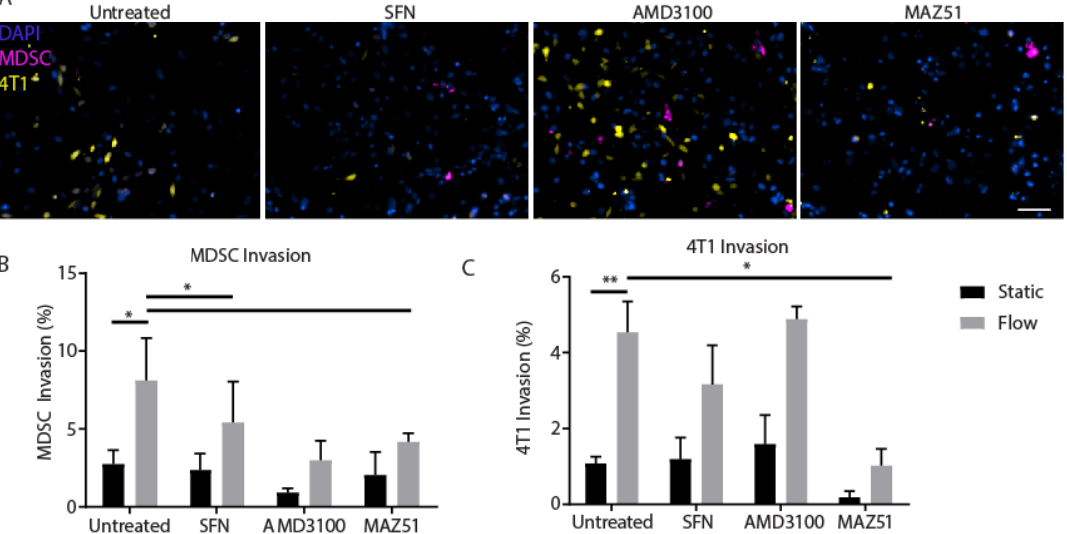
Figure 5 . Inhibition of VEGFR3 significantly decreases fluid-mediated invasion of 4T1s and MDSCs in the 3D tumor microenvironment co-culture model. Co-cultures of MDSCs, 4T1s, and LECs were treated with three inhibitors or untreated (DMSO) in tissue culture inserts. ( A ) Representative images of invading cells on tissue culture insert membranes for each inhibitor. Scale bar represents 200 µm. ( B ) Quantification of MDSC invasion in the presence of 2 µM SFN, 10 µM AMD3100, and 1 µM MAZ51 under static and flow conditions ( n = 3). ( C ) Quantification of 4T1 invasion in the presence of 2 µM SFN, 10 µM AMD3100, and 1 µM MAZ51 under static and flow conditions ( n = 3). Data and error bars are represented as mean ± SEM, *, p < 0.05 and ** < 0.01.